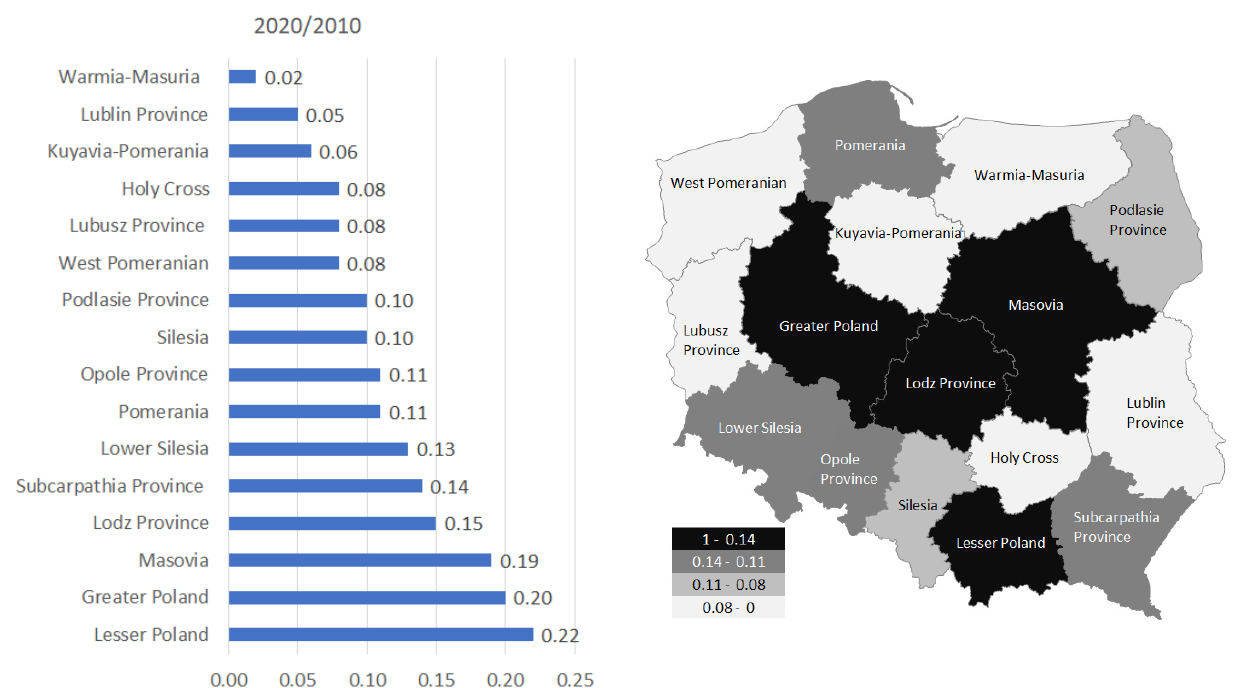
Figure 1. Groups and spatial differentiation of the synthetic measure of the quality of life in voi- vodships in Poland in 2010 and 2020. Source: own study based on the BDL CSO data.